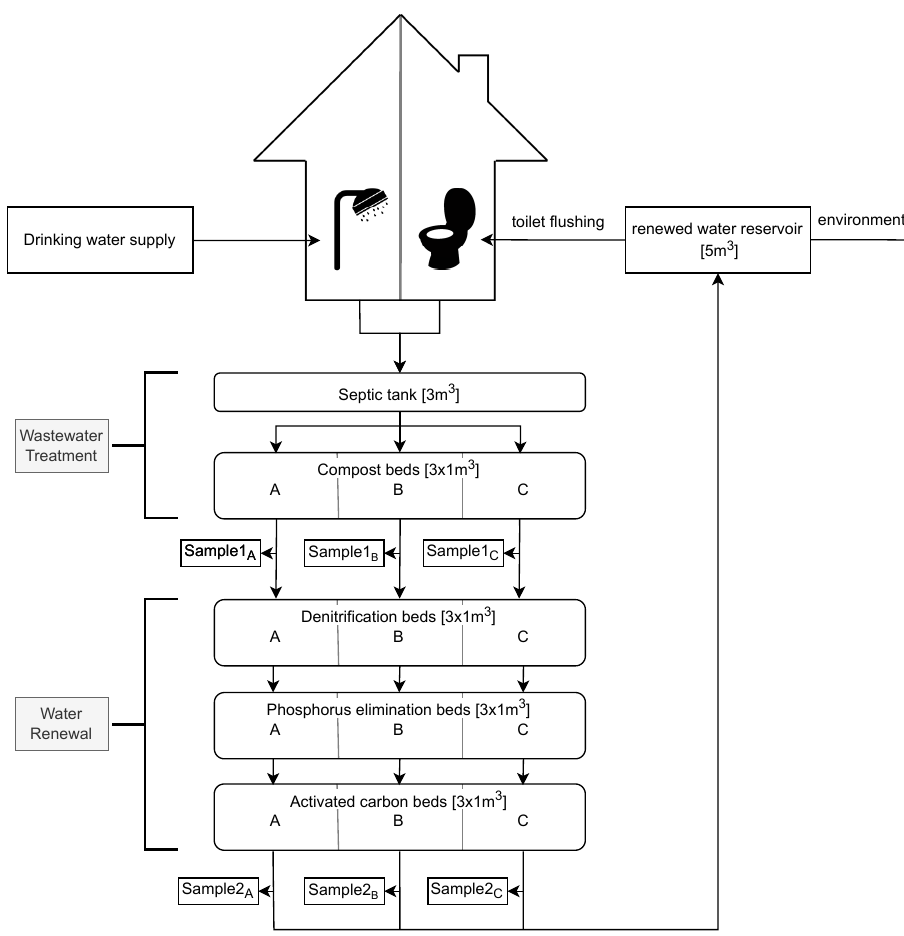
Figure 1. Scheme of the NTSW pilot plant (adapted from Halicki and Halicki [12]). The three parallel wastewater treatment and water renewal processes are conducted in different daily hydraulic loads, namely 70, 100 and 130 L/m 2 for the A, B and C letters,